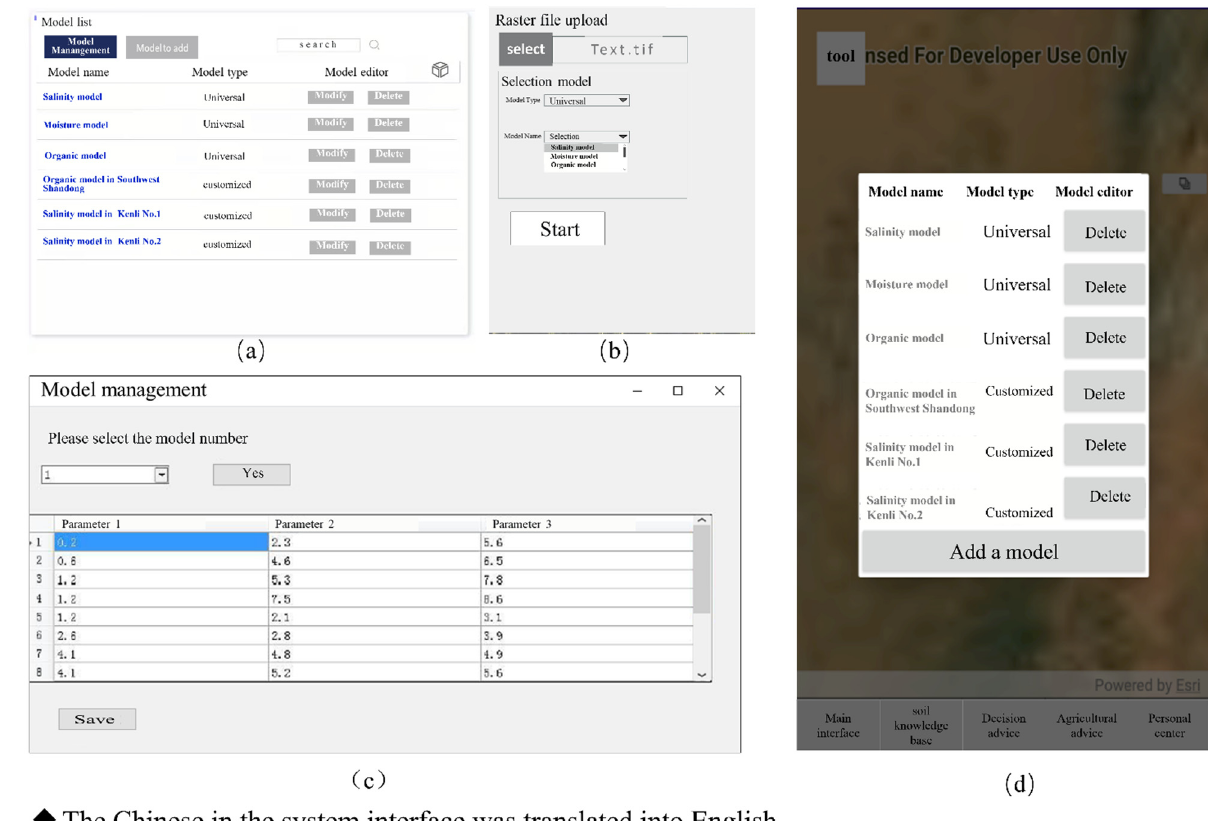
Figure 1. Operation interface of the management function of the quantitative inversion model. ( a ) The Web client model is modified; ( b ) The Web client model selection; ( c ) The PC client model management; ( d ) Mobile App side model management.